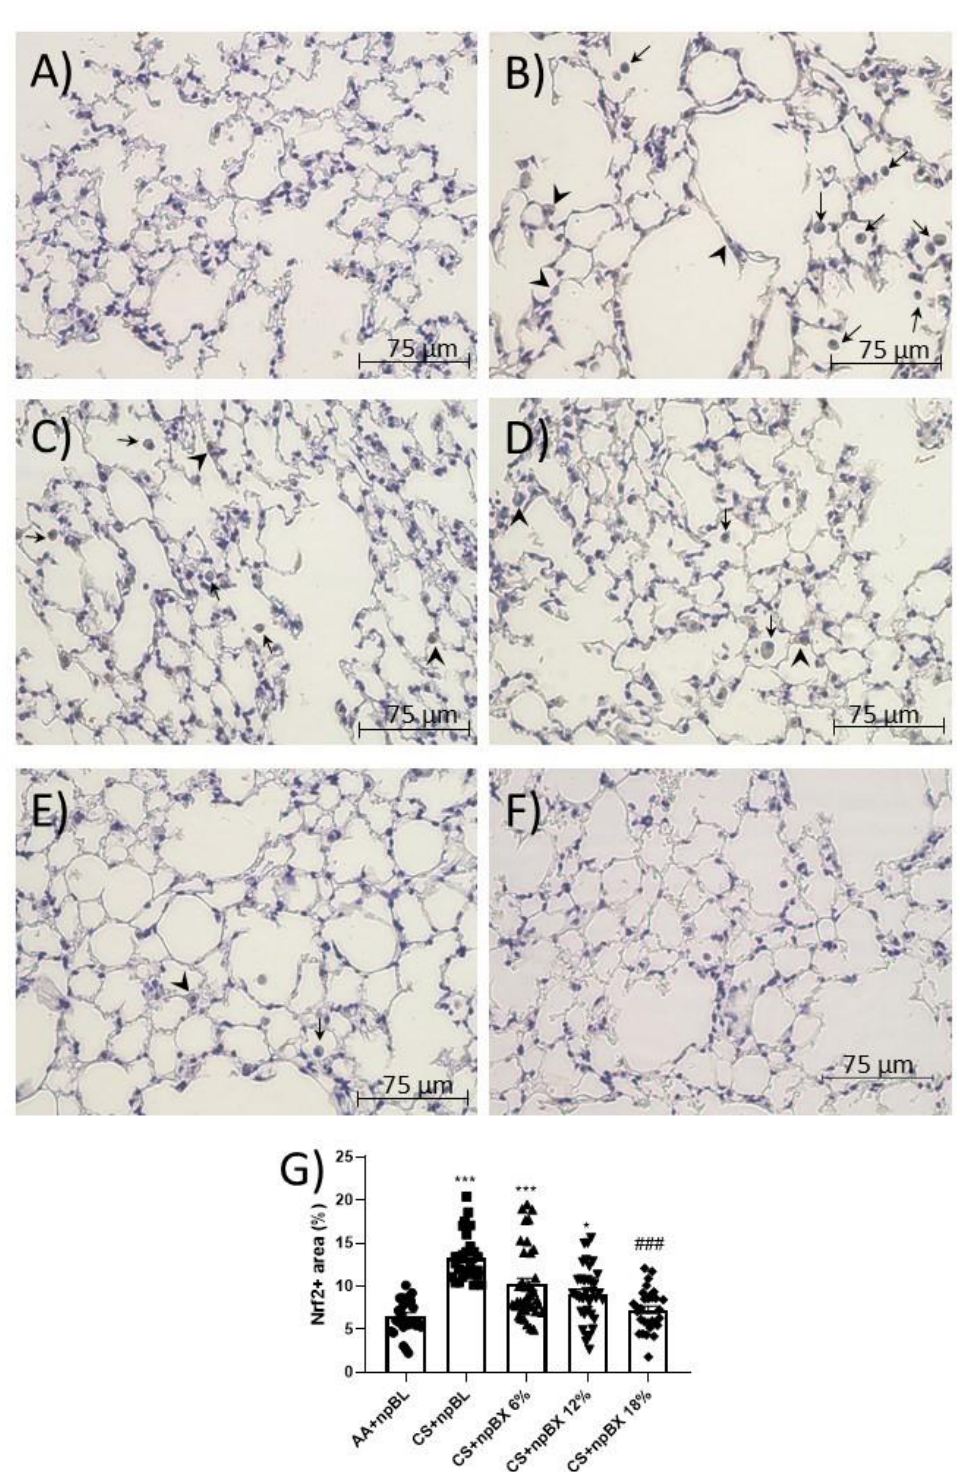
Figure 8. Immunohistochemistry for Nrf2. Lung sections stained for Nrf2 of ( A ) AA + npBL, ( B ) CS + npBL, ( C ) CS + npBX 6%, ( D ) CS + npBX 12%, ( E ) CS + npBX 18% and ( F ) negative control (lacking the primary antibody) mice. ( G ) Quantification of positive cells. Arrows and arrow heads indicate Nrf2 + cells into the alveolar space and in alveolar sept, respectively. Scale bar: 75 µm. Original magnification: 40x. * p < 0.05 and *** p < 0.001 compared to AA + npBL; # p < 0.05 and ### p < 0.001 compared to the CS + npBL group.